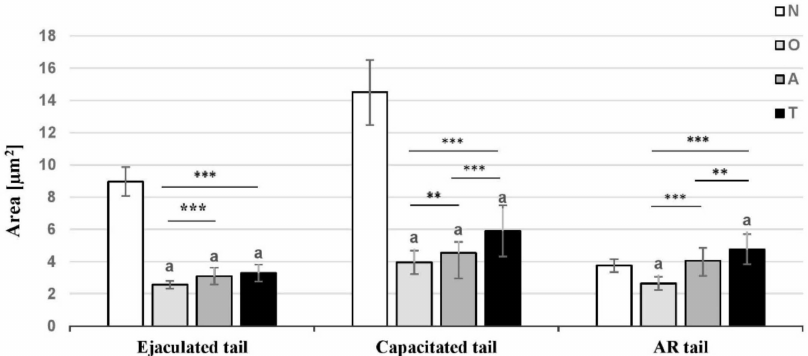
Figure 4. Measurements of area of tACE protein expression in ejaculated, capacitated and acro- some reacted (AR) sperm, visualized by indirect immunofluorescence in different cases of semen pathology N—normospermia, O—oligozoospermia, A—asthenozoospermia, T—teratozoospermia. The data represent mean values ± SD. Asterisk indicates significant differences between groups with semen pathology—** p < 0.01; *** p < 0.001; a—significance when compared to control value (normospermic